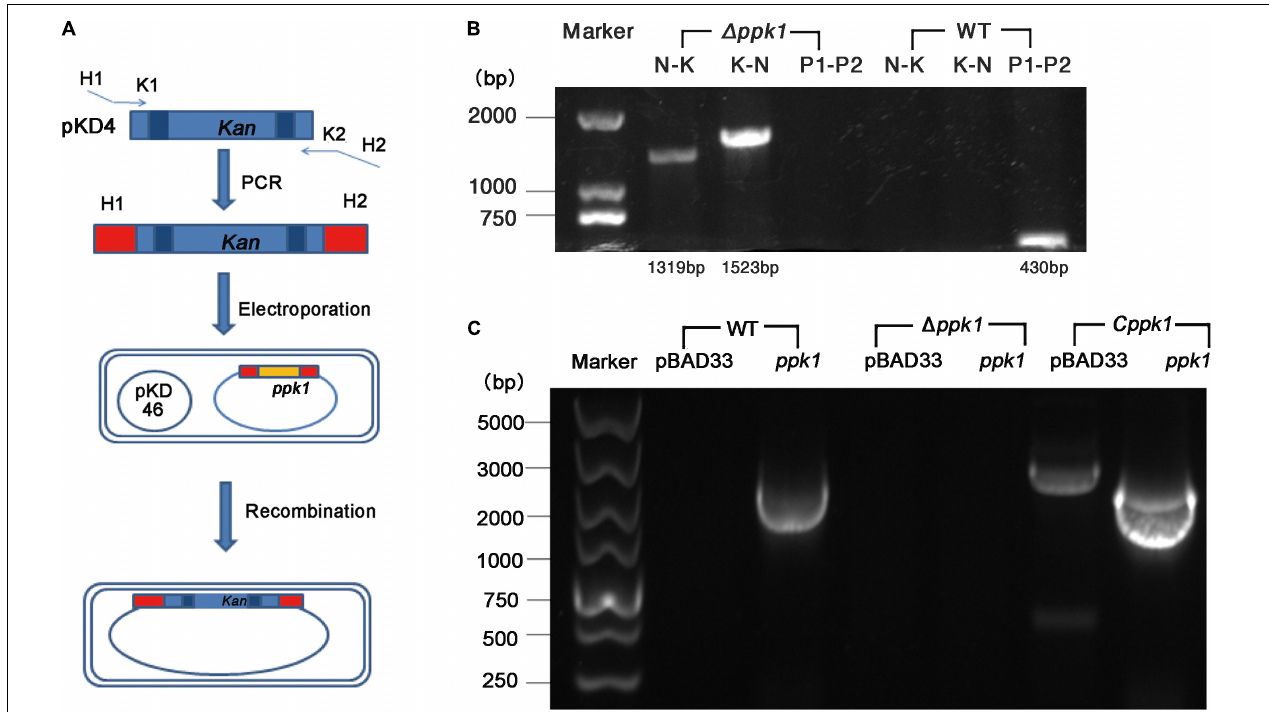
FIGURE 1 | Construction of the ppk1 deletion mutant ( (cid:49) ppk1 ) and complemented strain ( Cppk1 ) of EHEC O157:H7. (A) Schematic diagram of the λ red system homologous recombination. (B) The primers of lane 2 and 5 (N-K) were N1-F and Kana-R. The primers of lane 3 and 6 (K-N) were Kana-F and N2-R. The primers of lane 4 and 7 (P1-P2) were PPK-P1 and PPK-P2. (C) Two pairs of primers ( pBAD33-F/R and ppk-F/R ) were used to verify the complemented strain, which produced products of 2092 bp and 2268 bp, respectively. The Cppk1 strain contained both fragments, while WT strain contained only the 2092 bp, and the (cid:49) ppk1 strain contained